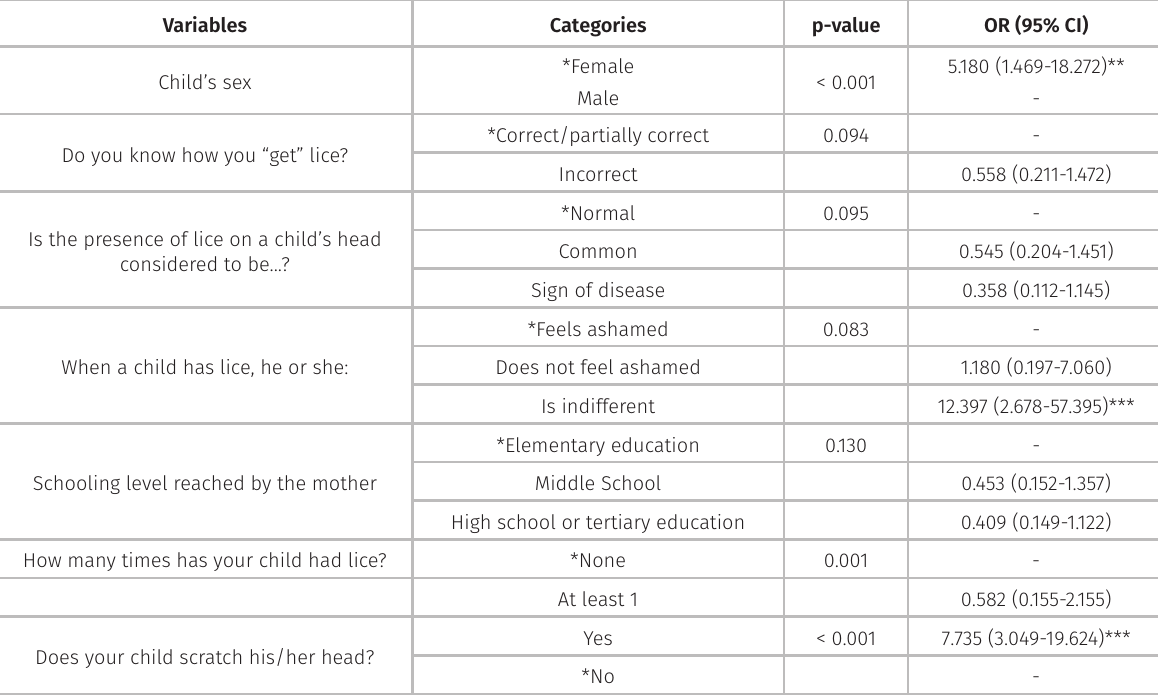
Table V. Association between presence of pediculosis and risk factors relating to information about pediculosis among the patients and guardians of children in years 1-5 at five municipal elementary schools in Niterói, RJ, 2020.